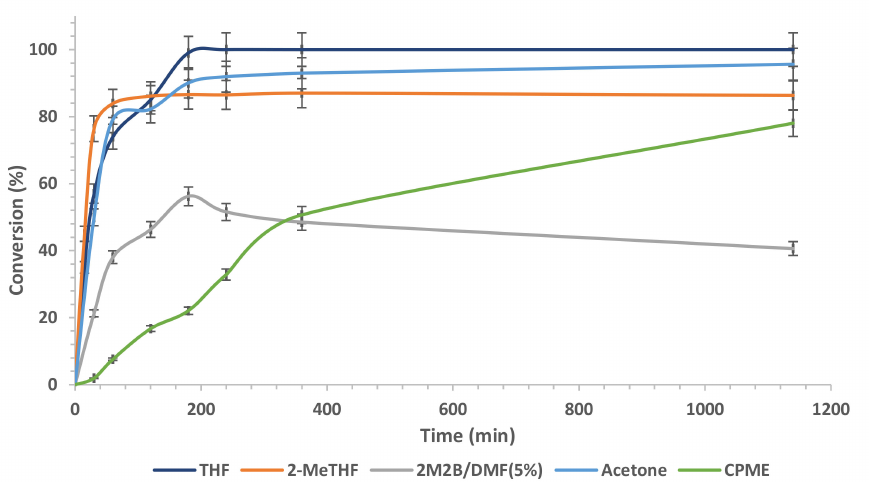
Figure 5. Comparison of conversion achieved with different organic solvents in the PSL-catalysed synthesis of 1e